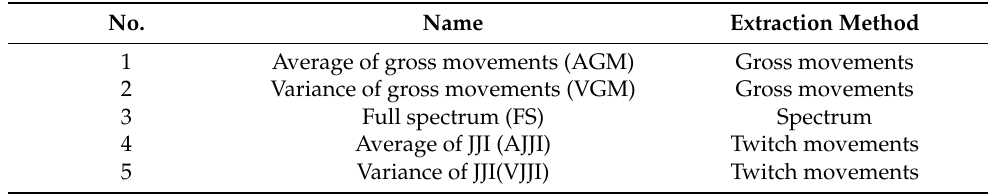
Table 2. Features of the first-step classifier.